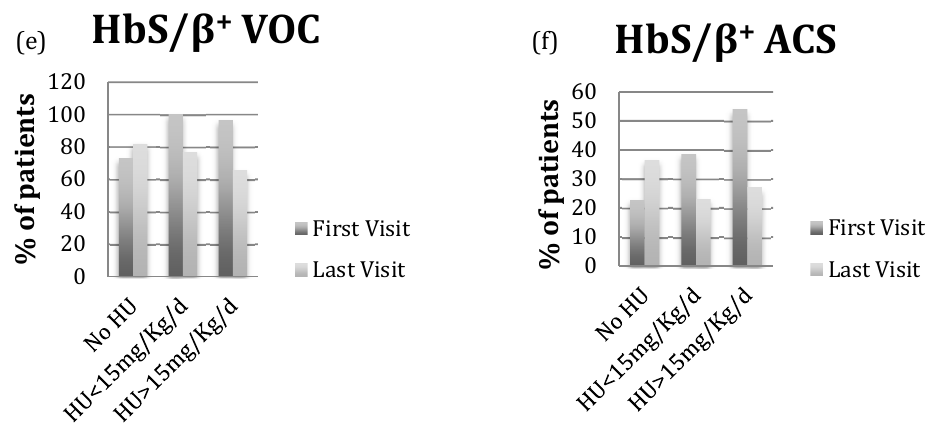
Figure 1. ( a , c , e ) VOC prevalence at first and last visit based on HU status in patients with HbS/S, HbS/ β 0 -thalassemia and HbS/ β + -thalassemia; ( b , d , f ) ACS prevalence at first and last visit based on HU status in patients with HbS/S, HbS/ β 0 -thalassemia and HbS/ β + -thalassemia.